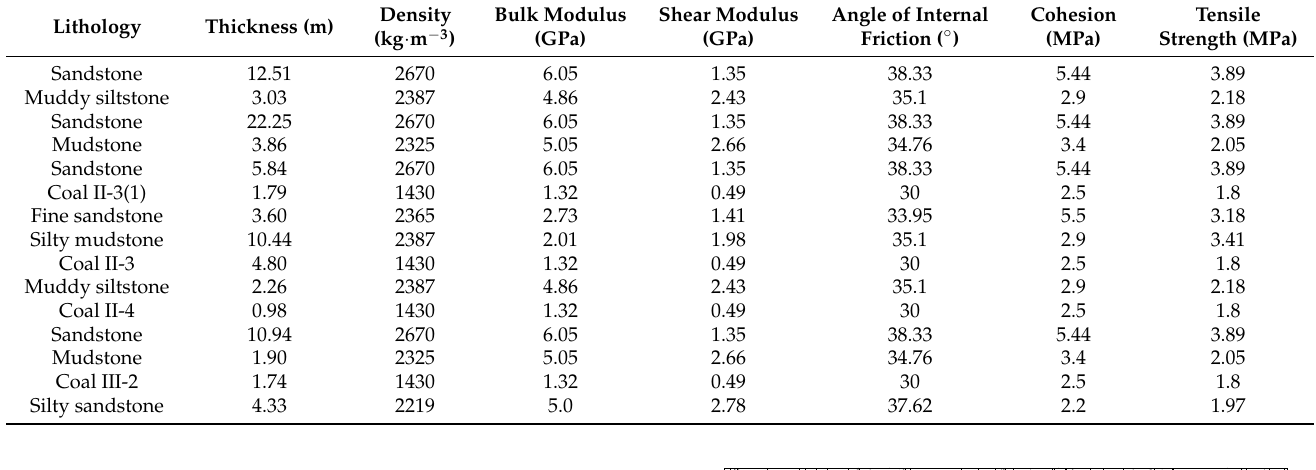
Figure 7. Numerical model. Table 1. Physical and mechanical parameters of coal–rock mass.